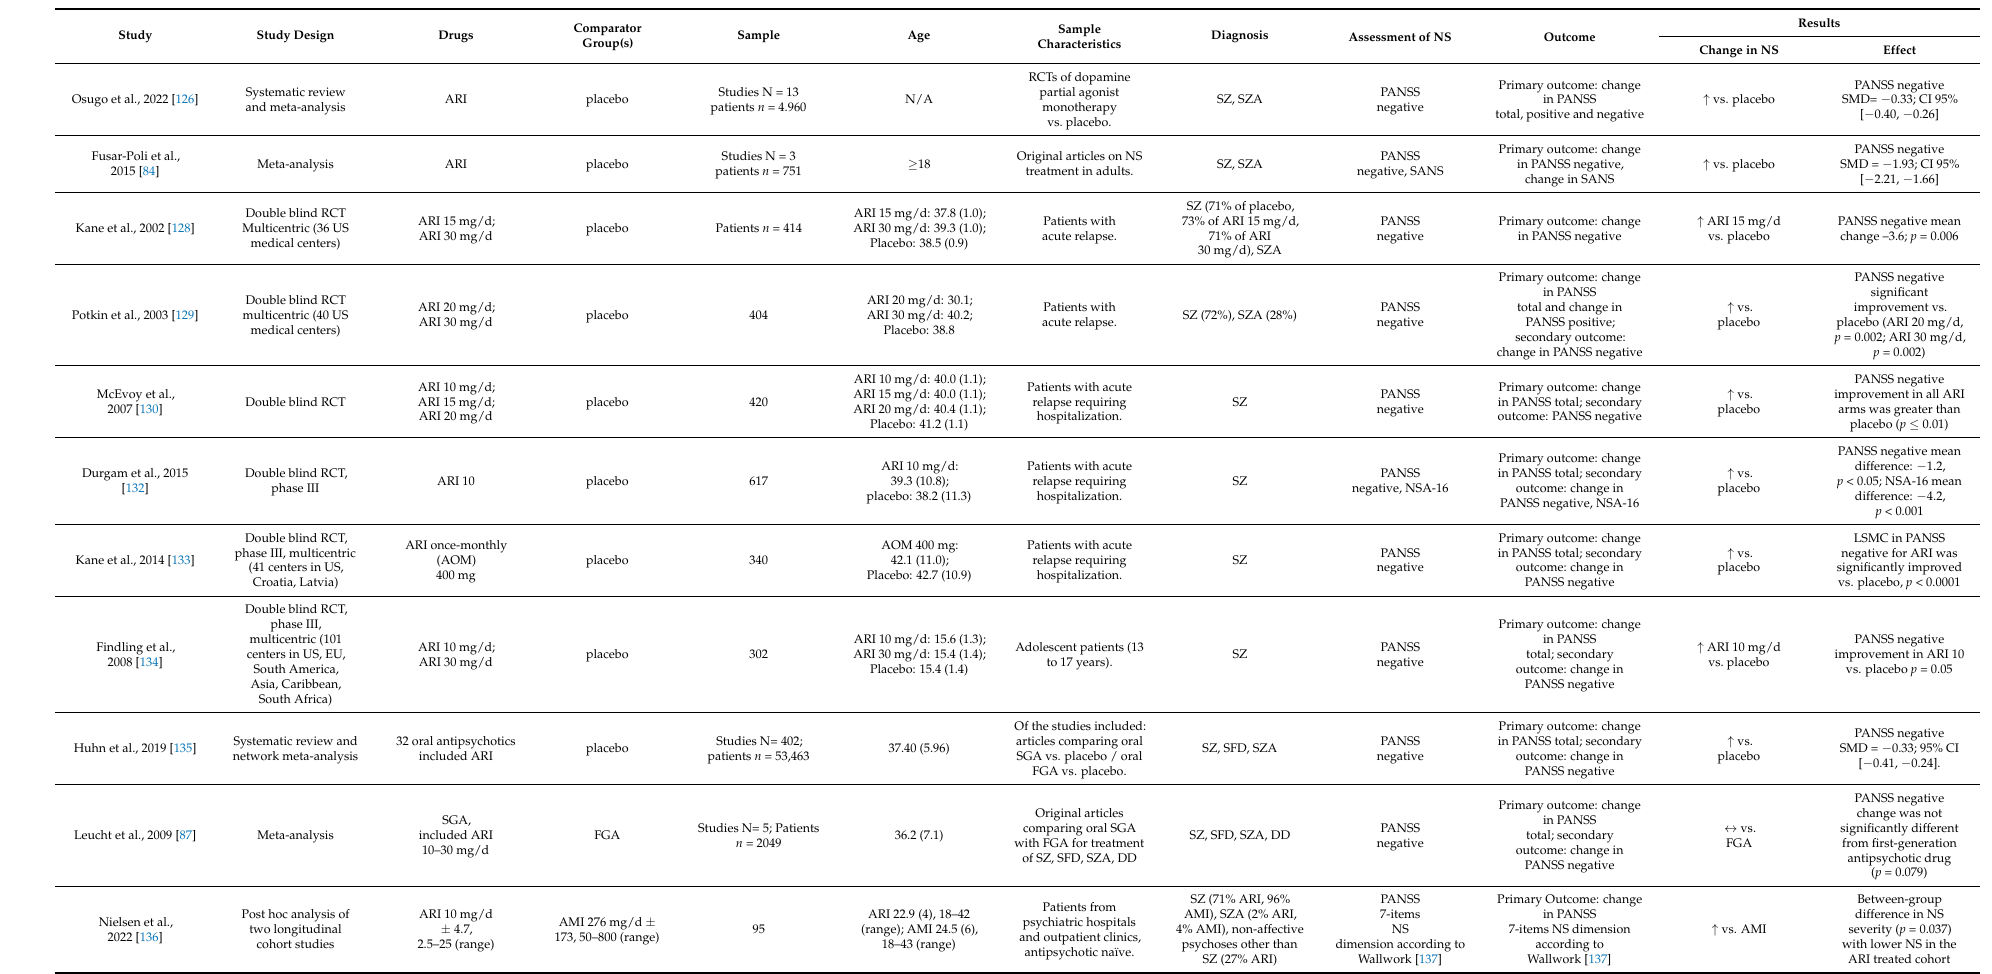
Table 2. Studies on the efficacy of aripiprazole in the treatment of negative symptoms.